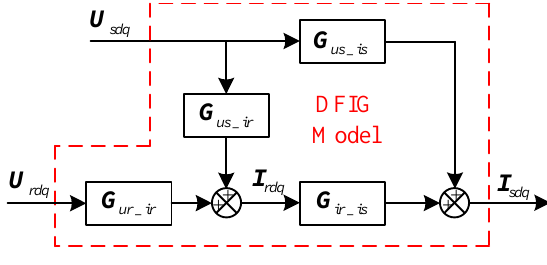
Figure 3. The model of DFIG in synchronous dq -frame.